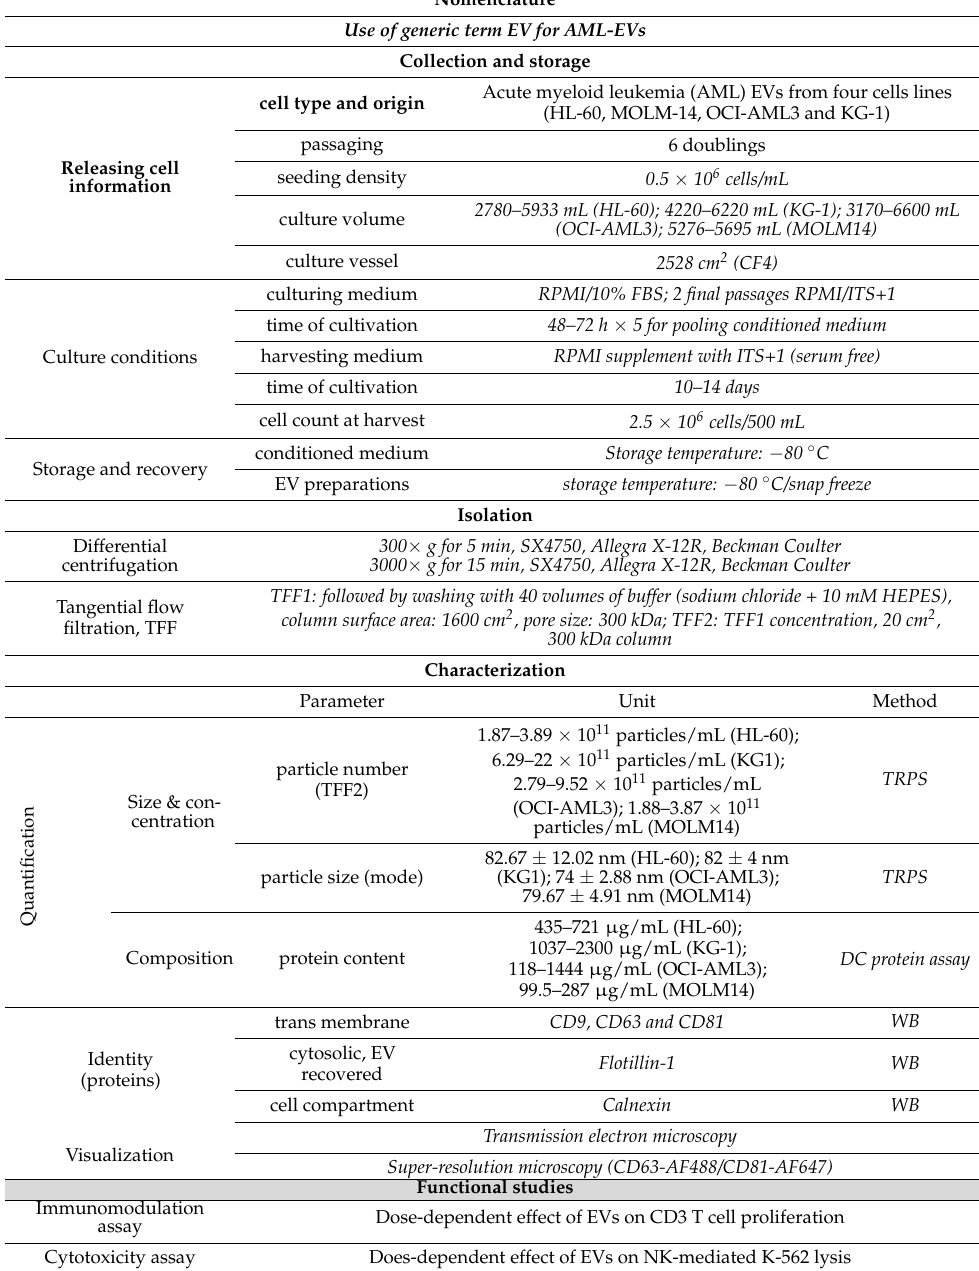
Table A2. Adherence to MISEV2018 criteria for research with EV material. Comments regarding EV nomenclature, isolation, characterization, collection, and storage conditions, as well as functional studies, were